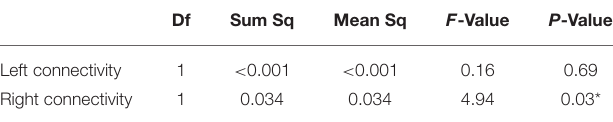
TABLE 3 | Differences between TLE and controls on connectivity variables (MANOVAs). Df Sum Sq Mean Sq F -Value P -Value Left connectivity 1 < 0.001 < 0.001 0.16 0.69 Right connectivity 1 0.034 0.034 4.94